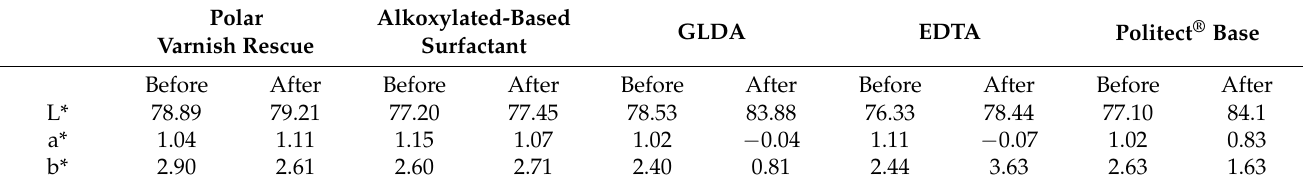
Table 7. Colorimetric measurements after cleaning tests. All measures are averaged. SDL* = 2;